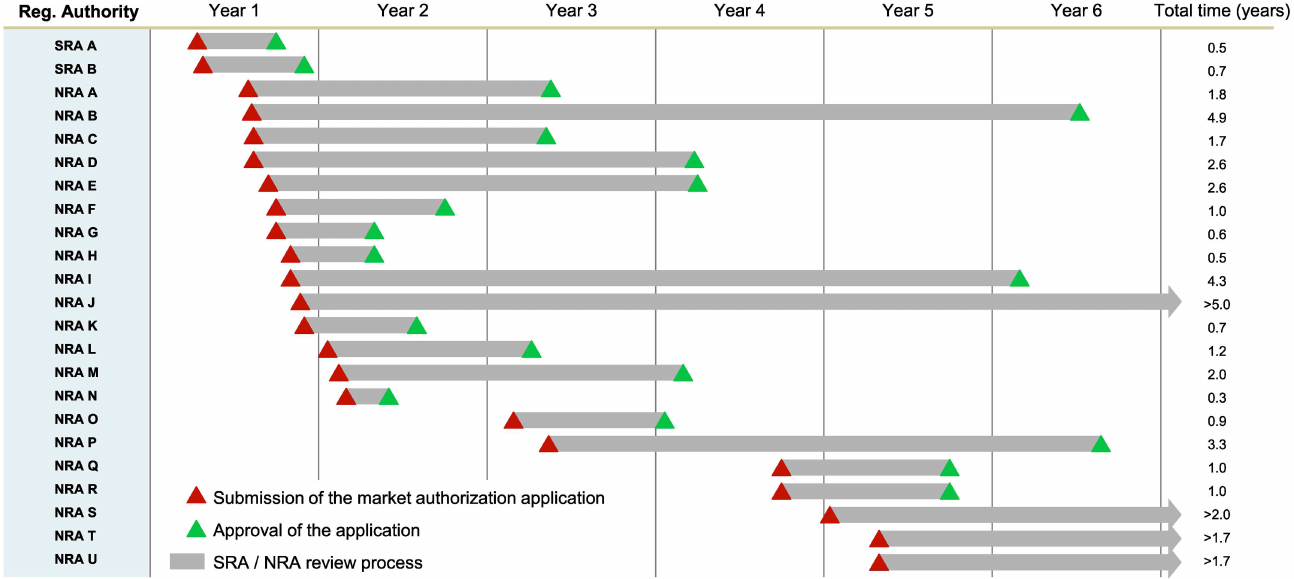
Fig 3. Registration Application Submissions and Approval in SSA for an anonymized antiretroviral drug, demonstrating 1) the variancein approval timelines across SSA countries and 2) the spread in manufacturer submissions. Red triangles represent the moment of dossier submissionto the SRA or NRA, green trianglesthe market authorization approvalby the NRA, and the grey arrows the review process.